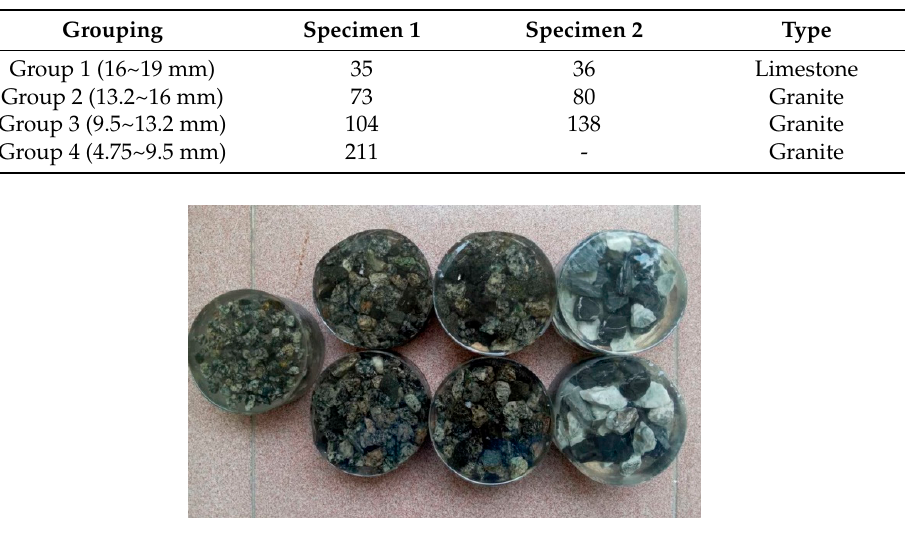
Table 1. The number and type of aggregates in specimens.